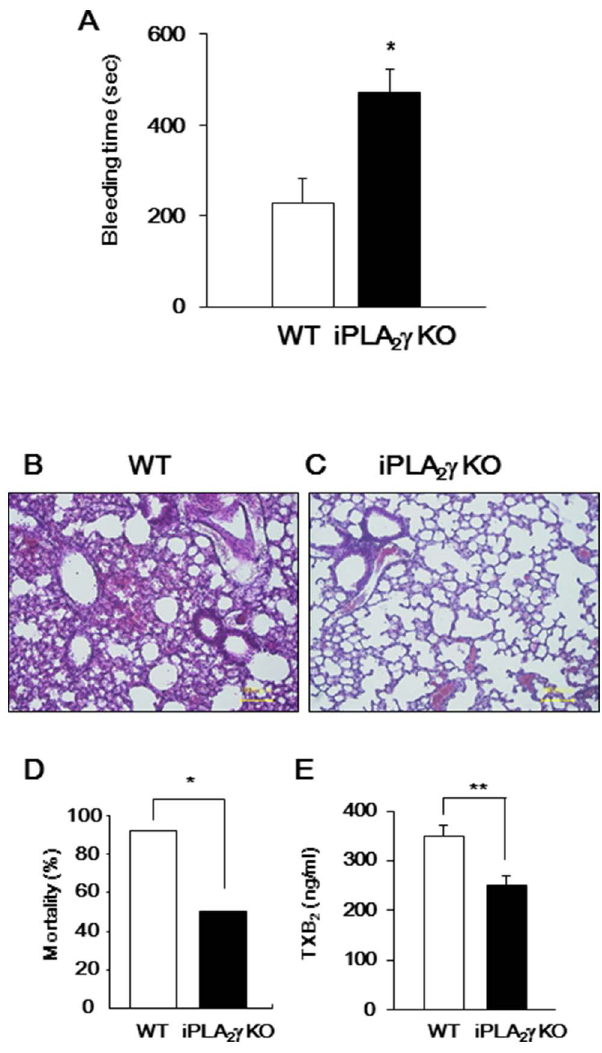
Figure 7. Impaired hemostasis and thrombus formation in iPLA 2 c -KO mice. (A) Bleeding times for WT (open column; n=9) and iPLA 2 c -KO (closed column; n=11) mice. Data are mean 6 SEM. ** P , 0.01 between iPLA 2 c -KO and WT. (B–D) Thrombotic challenge in WT (n=13) and iPLA 2 c -KO mice (n=12). (B and C) Histological examination of lungs from (B) WT and from (C) iPLA 2 c -KO mice killed 2 min after injection of 0.25 mg/kg collagen and 20 mg/kg epinephrine mixure. Representative results of at least three experiments are shown. (D) Data represent percentage of deaths within 1 hr after injection of collagen and epinephrine mixure. P values were determined by Fisher’s exact test: * P , 0.05 between iPLA 2 c -KO (n=12) and WT (n=13). (E) Serum TXB 2 content after injection of collagen and epinephrine mixture. Data are mean 6 SEM. * P , 0.05 between iPLA 2 c -KO (n=3) and WT (n=6).